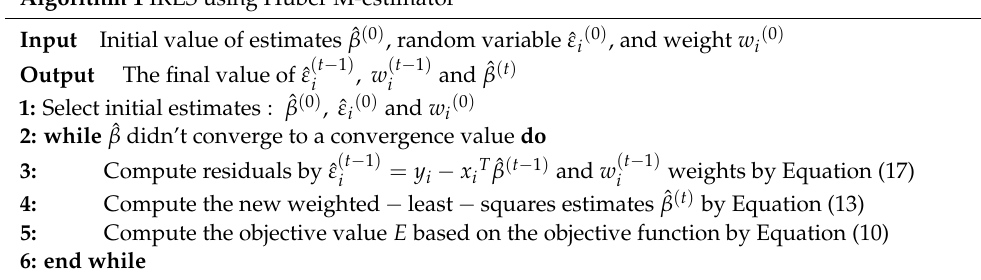
Algorithm 1 IRLS using Huber M-estimator